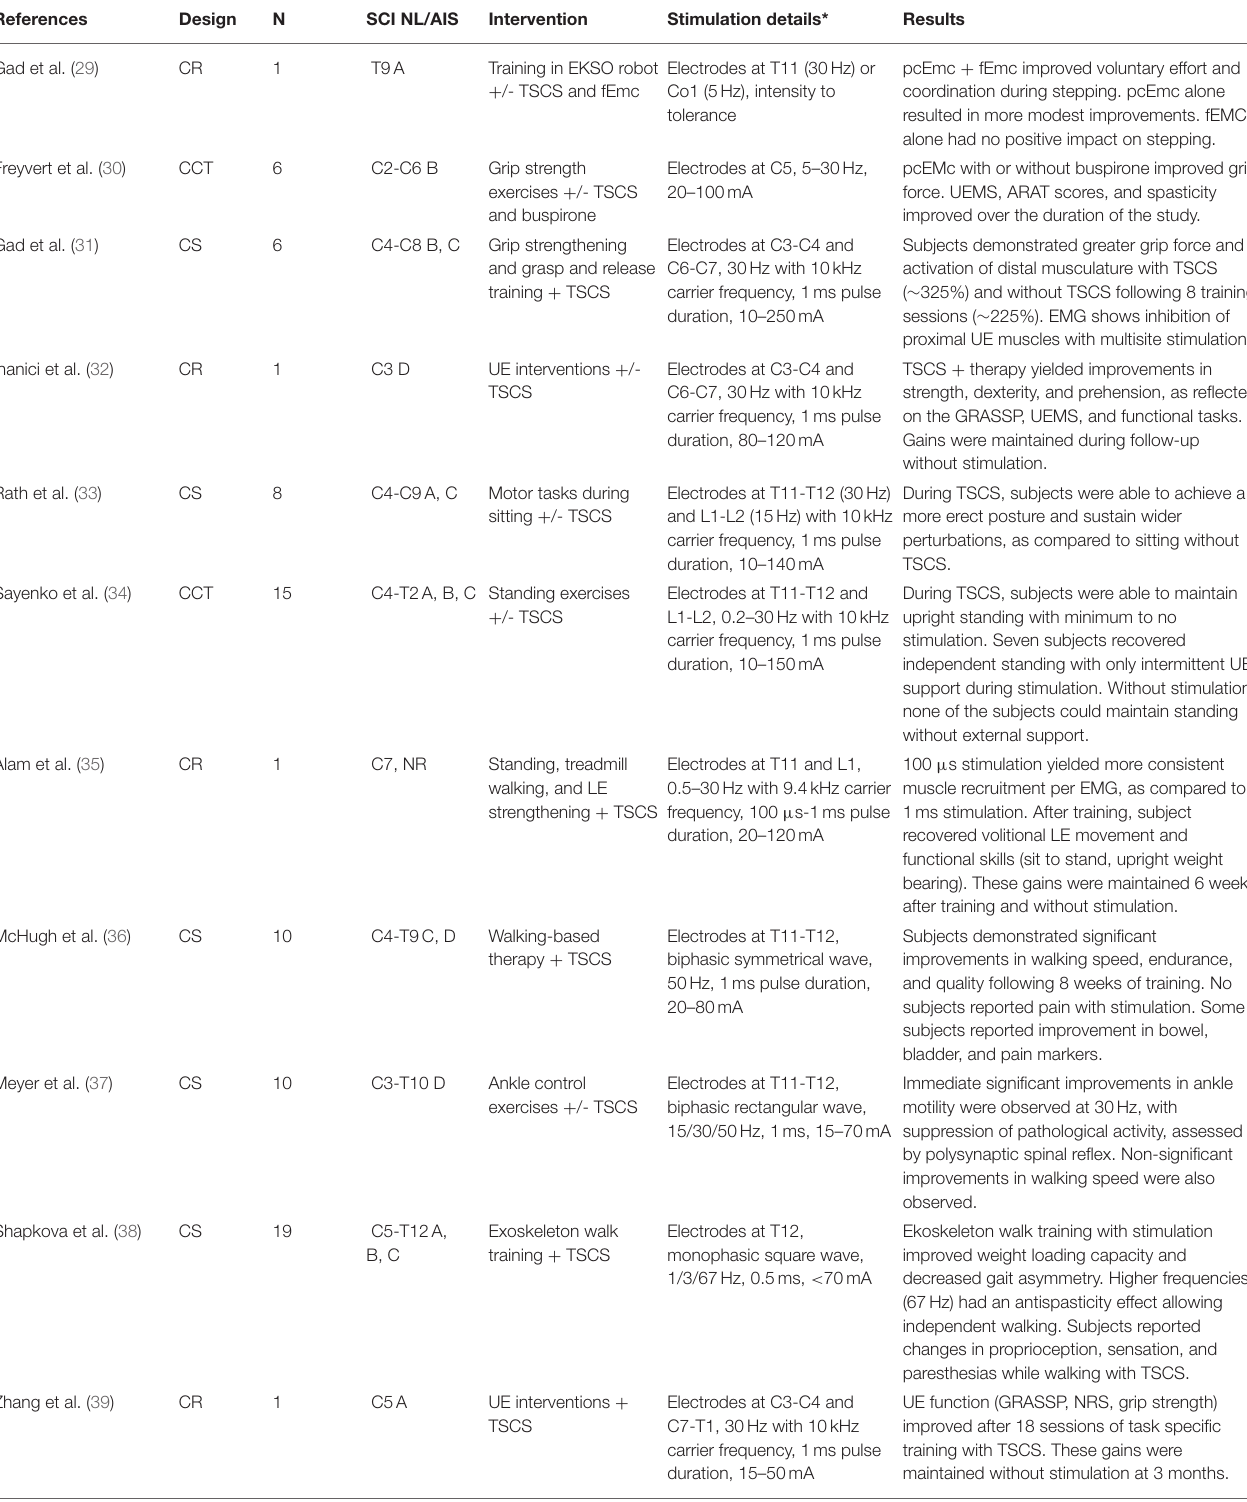
TABLE 1 | Key study elements and brief